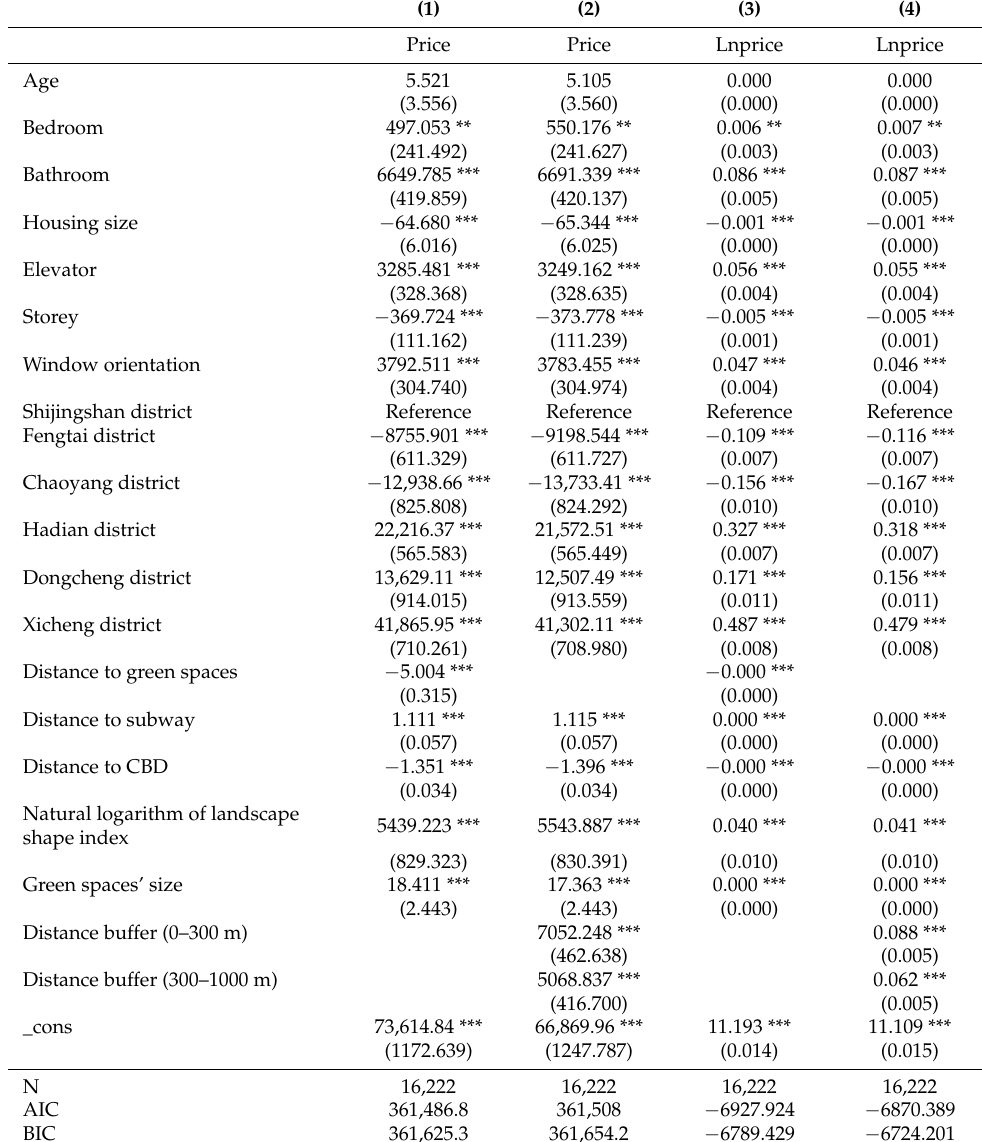
Table 2. Hedonic price model incorporating green space